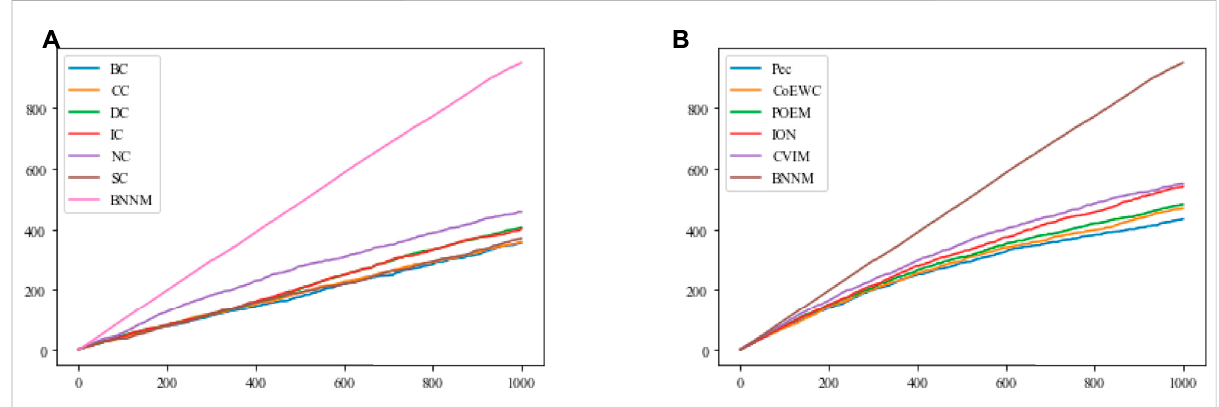
FIGURE 3 Comparison results between TNNM and 11 competitive methods based on the jackknife method and the DIP2010 database. (A) Shows comparison results between BC, CC, DC, IC, NC, SC and TNNM, and (B) shows comparison results between Pec, CoEWC, POEM, ION, CVIM